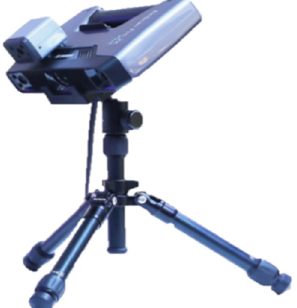
Appl. Sci. 2022 , 12 , x FOR PEER REVIEW Figure 2. Scanner. Figure 2. Scanner.